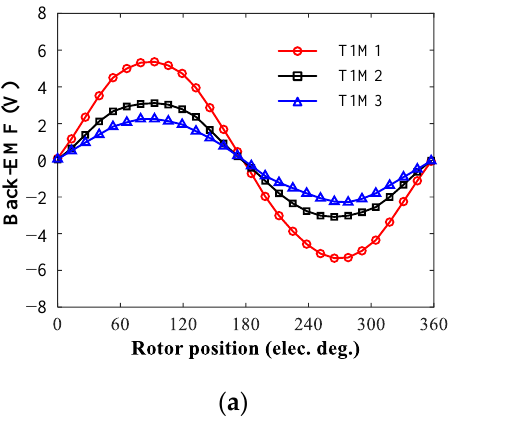
Figure 9. Measured no-load back-EMF of the investigated DS-PMM in three operating modes with different WS circuit. ( a ) Type I. ( b ) Type II.